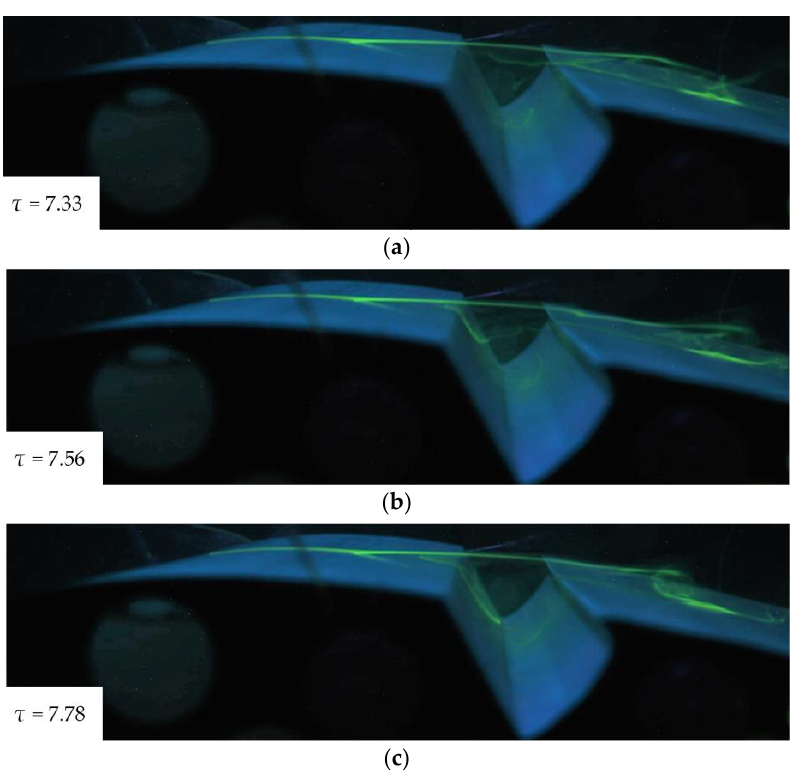
Figure 17. Flow images for cavity A at Re = 2 × 10 4 , α = 6°: ( a ) τ = 7.33; ( b ) τ = 7.56; ( c ) τ = 7.78.